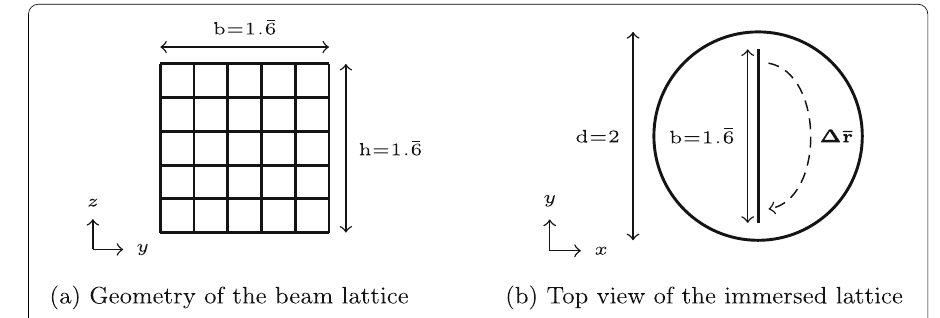
Fig. 11 Configuration of the rotating lattice immersed in a cylindrical fluid tank